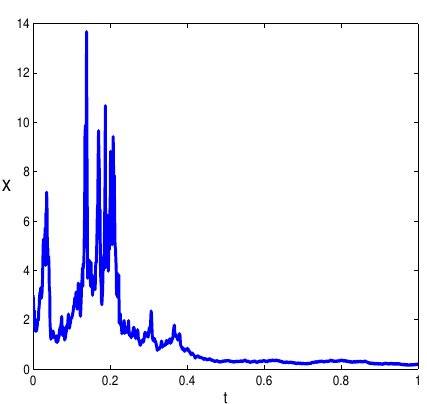
Figure 2. Dynamic responses for the second case.